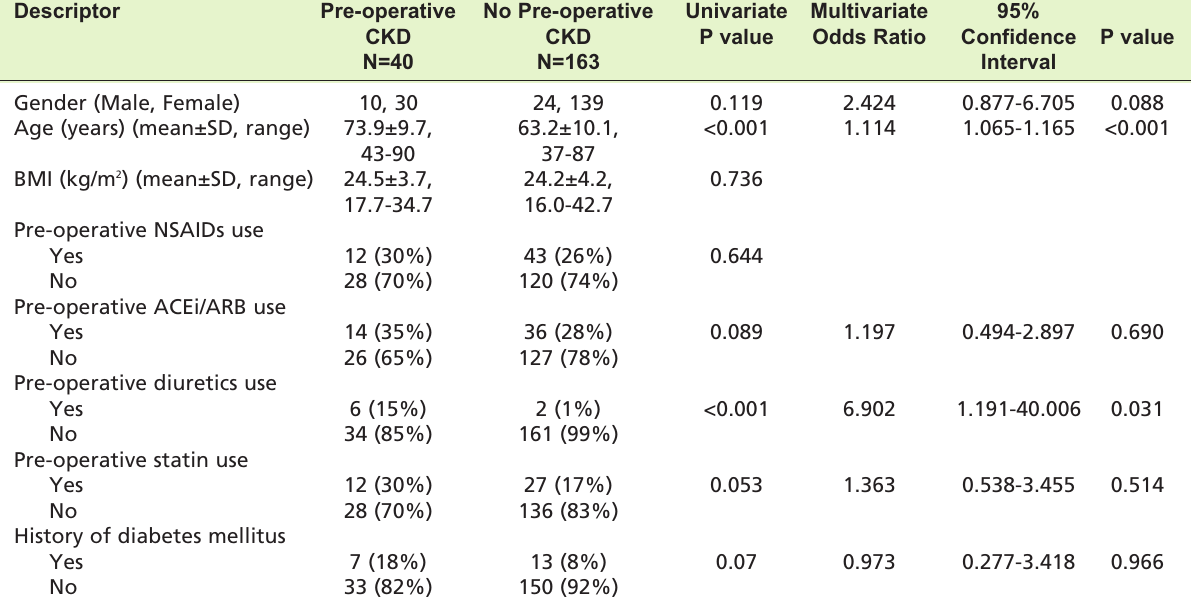
Factors associated with pre-operative CKD Table II: